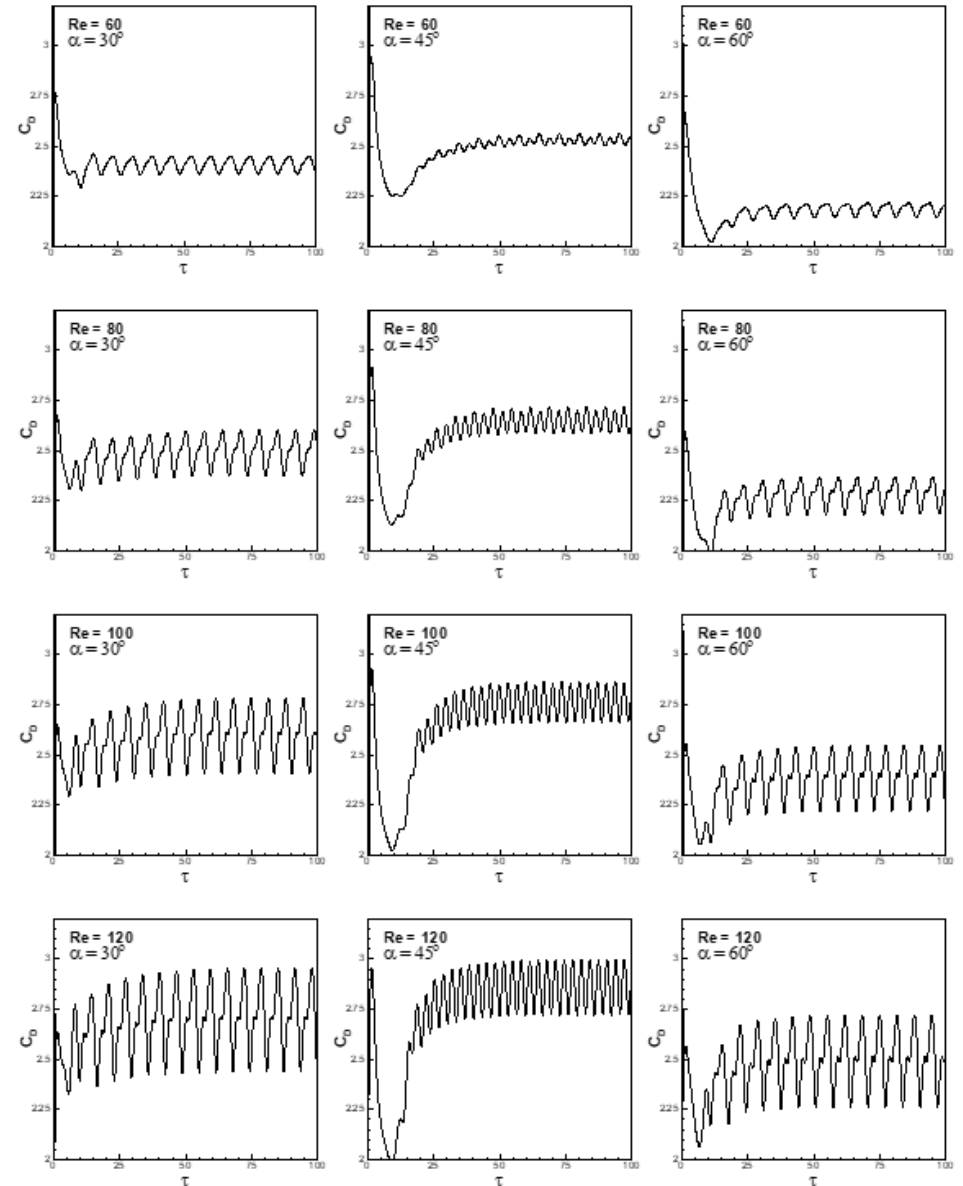
Figure 17. Variation of drag coefficient with non-dimensional time for 60 ≤ Re ≤ 120 and 30° ≤ α ≤ 60° at Ri = 0.2.